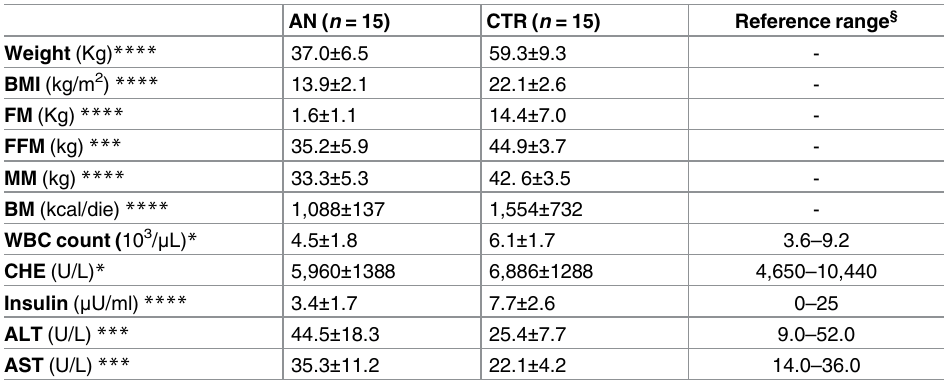
Table 1. Characteristics of the study population.